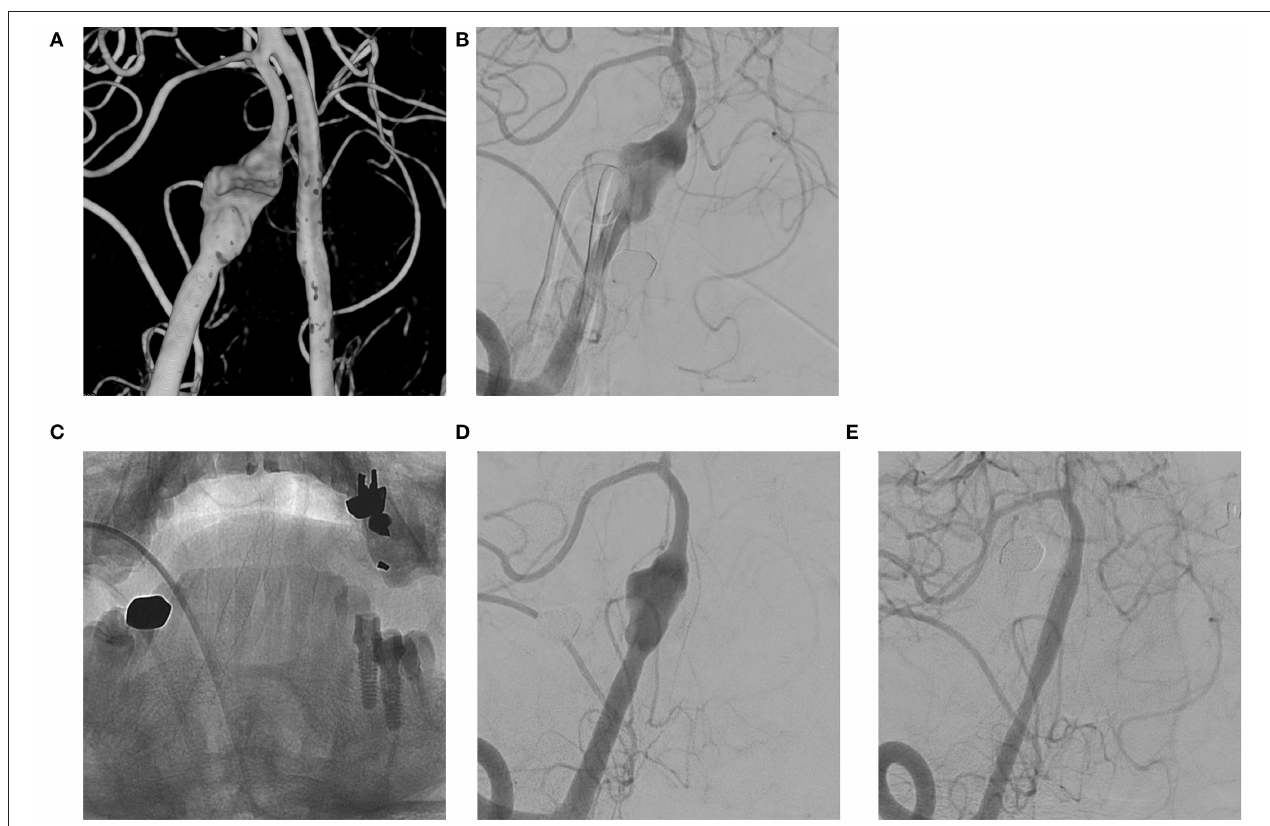
FIGURE 1 | (A,B) VADA with dilation only without stenosis at the right distal vertebral artery; (C,D) Flow diverting stent deployed at the lesion; (E) Complete occlusion of the aneurysm at 6 month follow-up